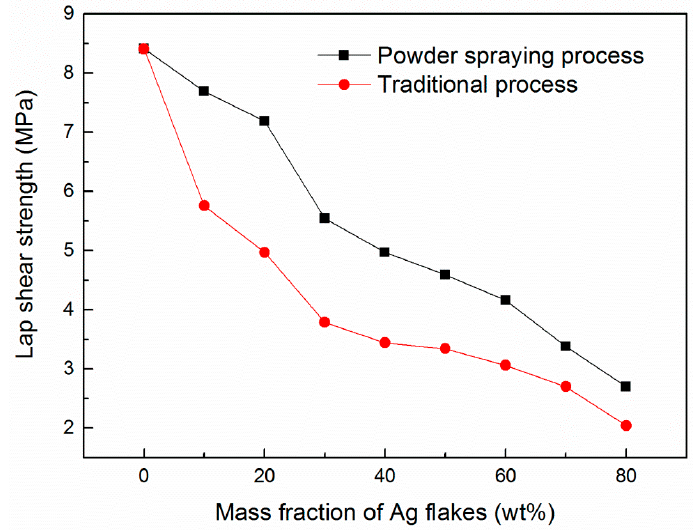
Figure 2. Lap shear strength of the ECAs fabricated by the powder spraying process and the conventional process. conventional